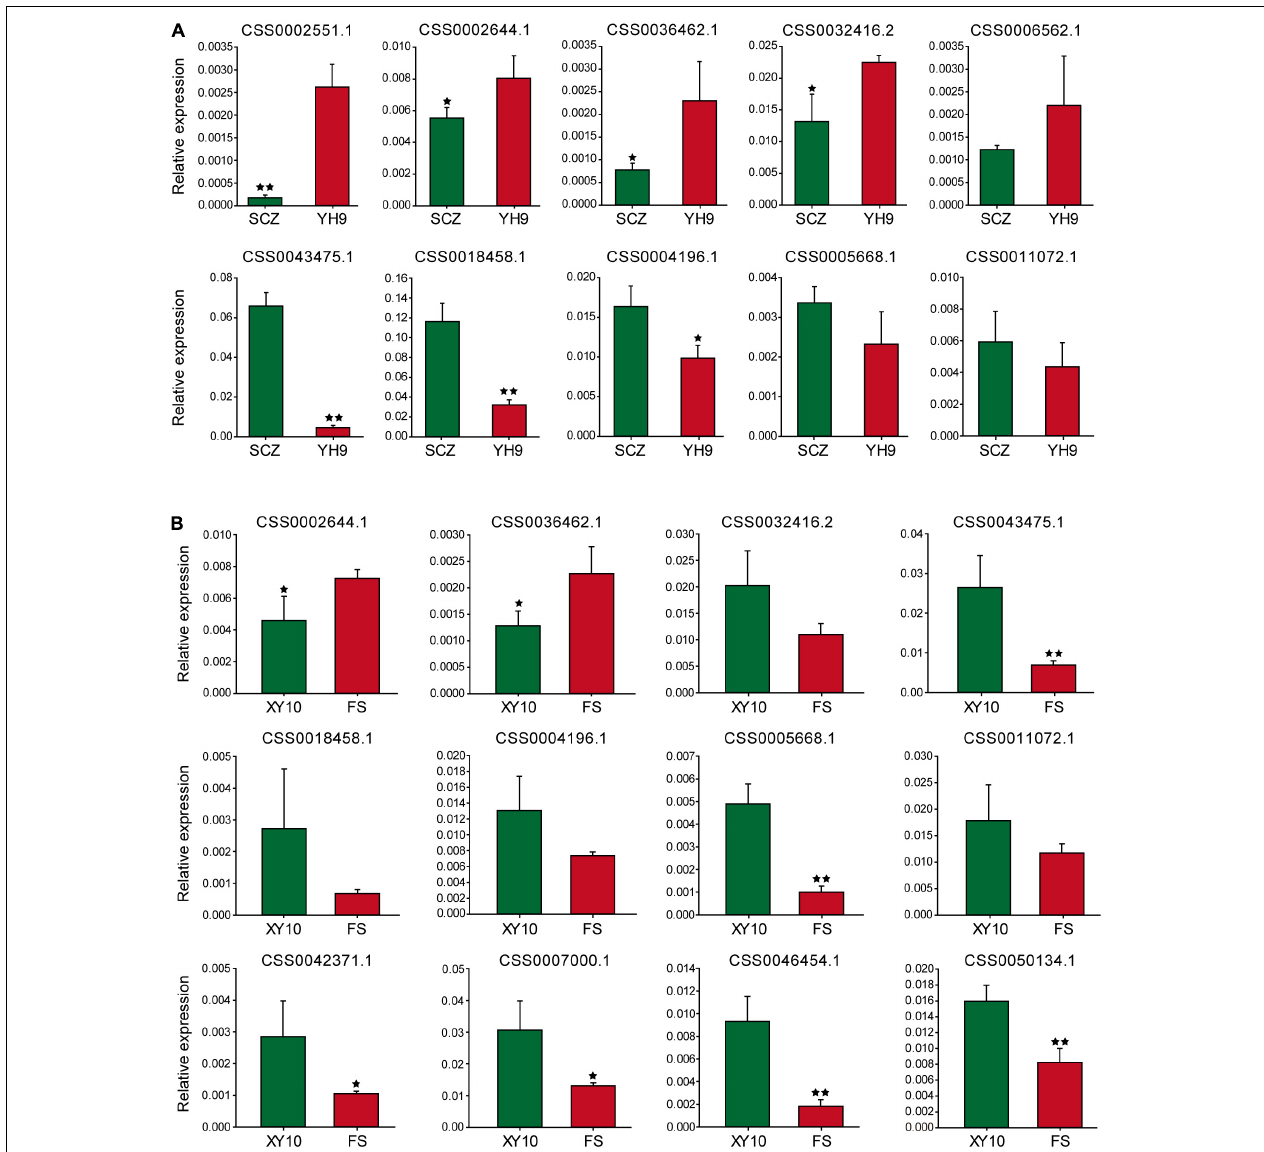
FIGURE 5 | The expression of genes near the potential QTL analyzed using qRT-PCR. (A) Shuchazao and Yinghong 9, (B) Xinyang 10 and Foshou. * and ** represent significant differences when p < 0.05 and p < 0.01, respectively.